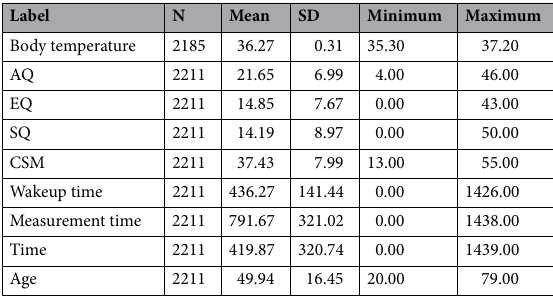
Table 1. Descriptive statistics of data in Survey 1.